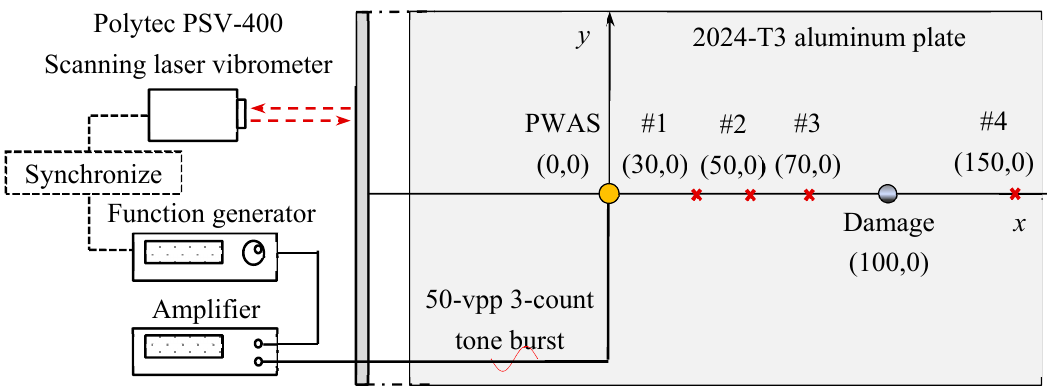
Figure 4. Schematic of an experimental setup using PWAS and scanning laser Doppler vibrometer (SLDV) for damage detection.